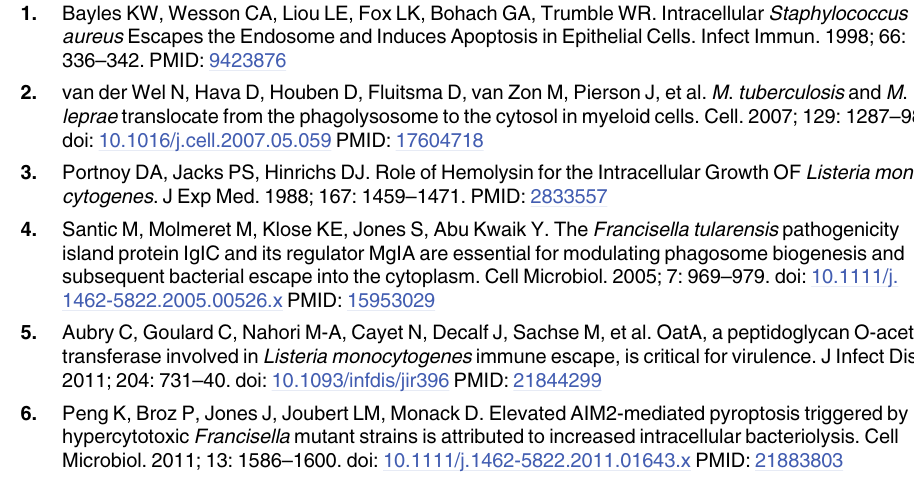
S1 Table. Strains used in this study. L . monocytogenes (top) and E . coli (bottom) strains used in this study. Strain designation, genotype, and source is listed left to